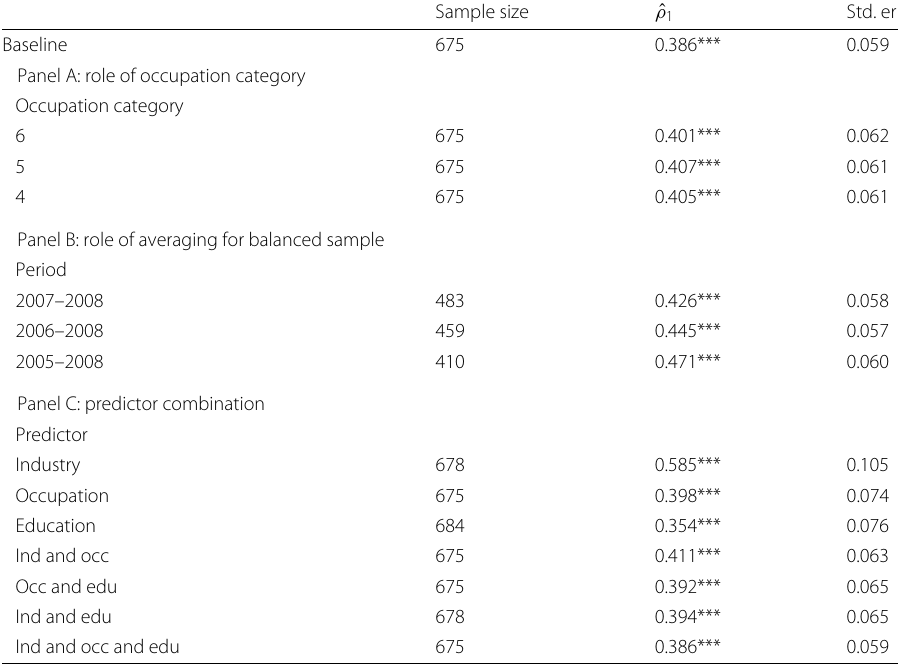
Table 3 Sensitivity of intergenerational earnings